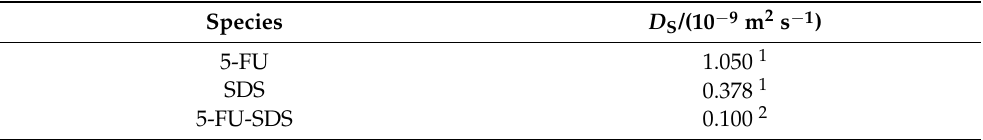
Table 6. Limiting diffusion coefficients, D s , of species present in the system 5-FU + SDS at T = 298.15 K and P = 101.3